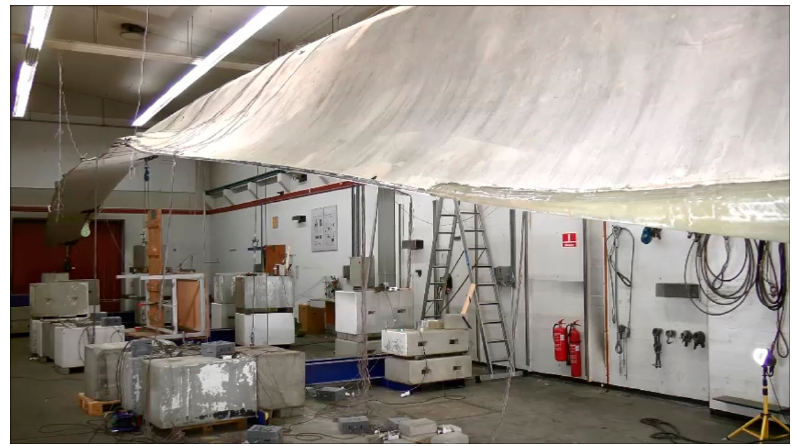
Figure 8. Full-scale testing: A 34 m long wind turbine blade subjected to static test in a combined flapwise and edgewise load direction.